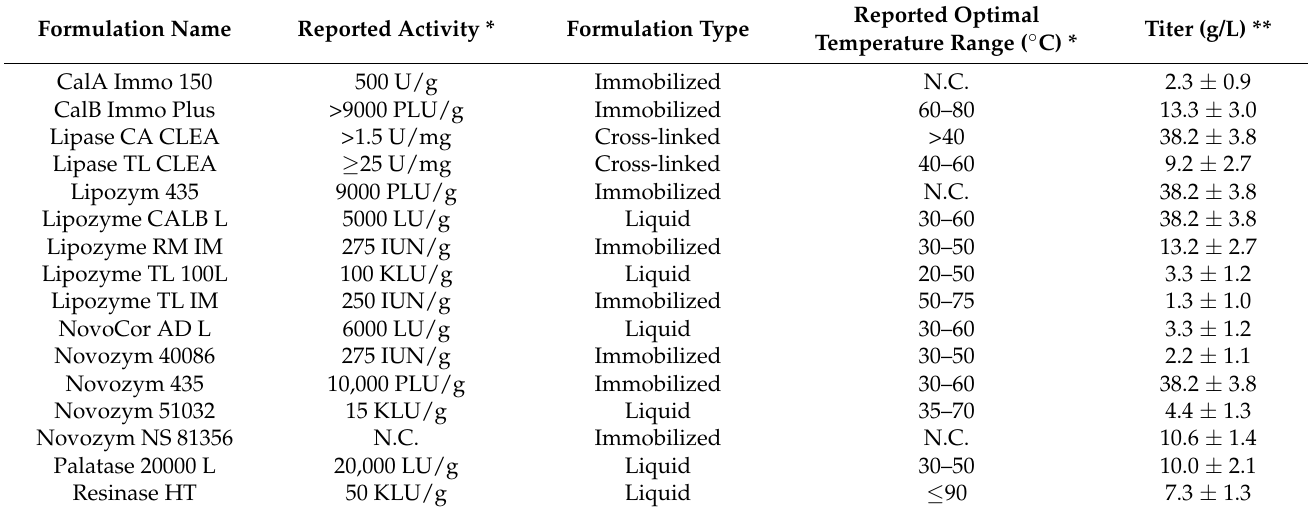
Table 2. Titer (g/L) of SL obtained after 48 h with commercially available enzyme formulations.